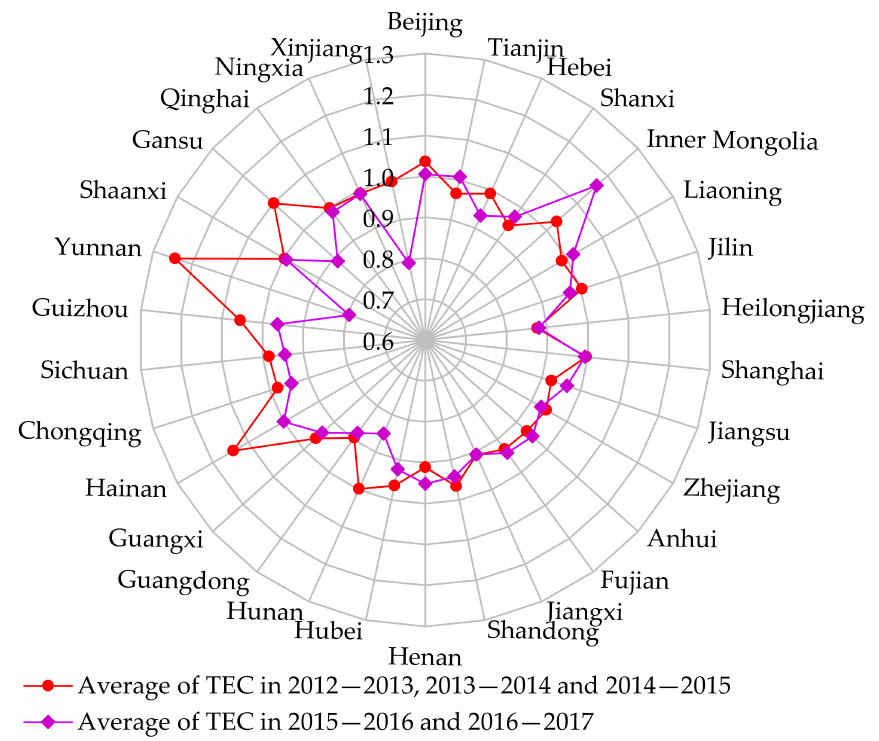
Figure 7. The change in technical efficiency (TEC) of the industrial sector in various provinces from